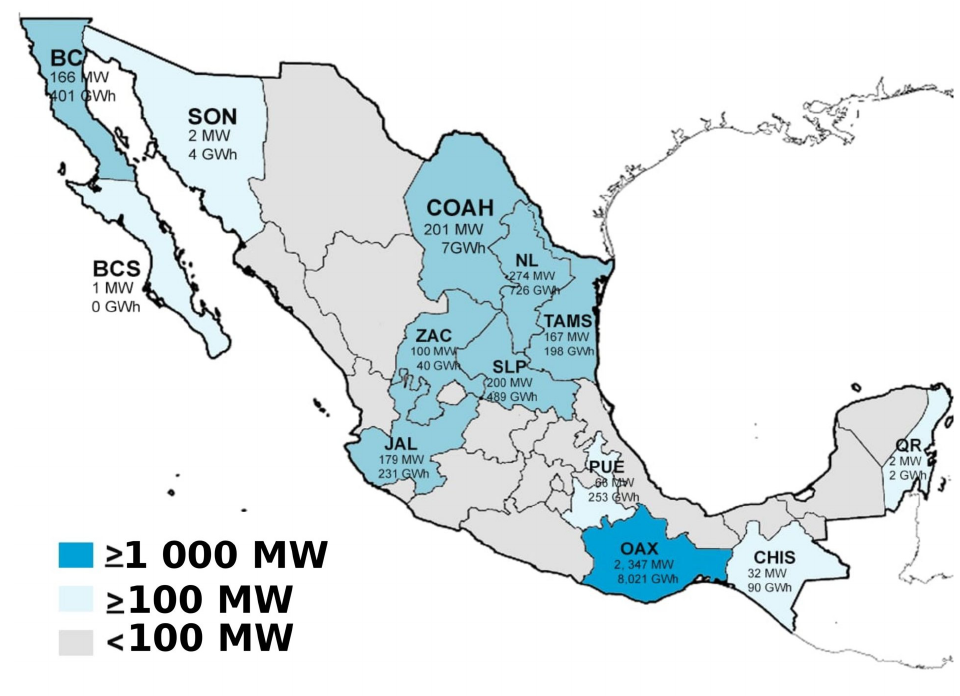
Figure 1. Installed capacity and wind-generated electricity, 2016 [2]. BC Baja California, BCS